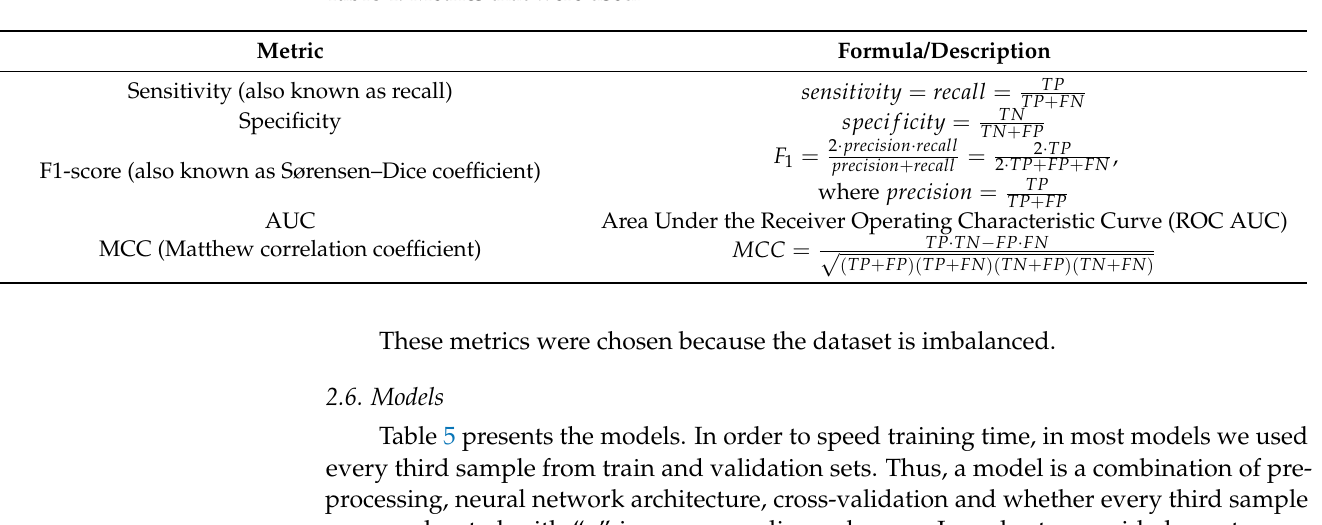
Table 4. Metrics that were used.